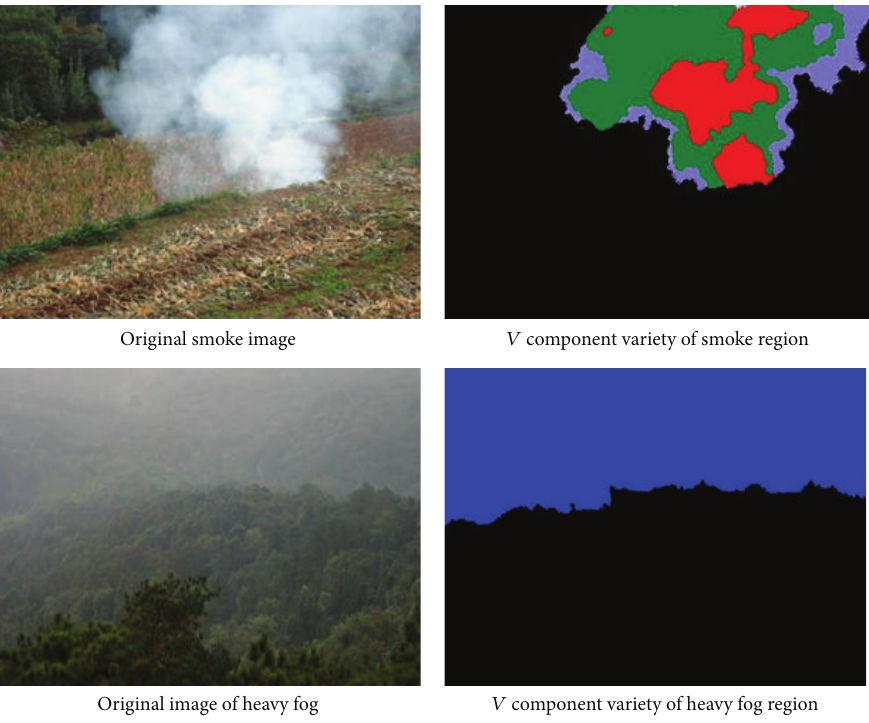
Figure 8: 𝑉 component value variety of smoke region and heavy